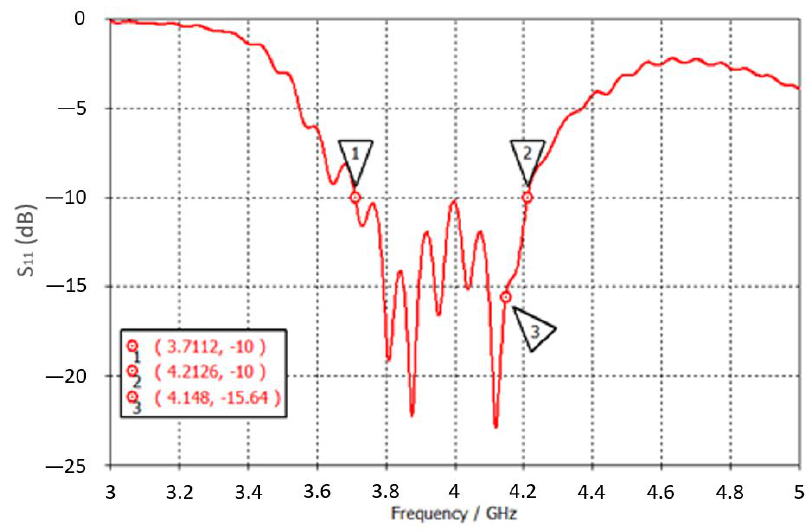
Figure 8. Reflection coefficient of the array antenna combined with a 2.4-m parabolic